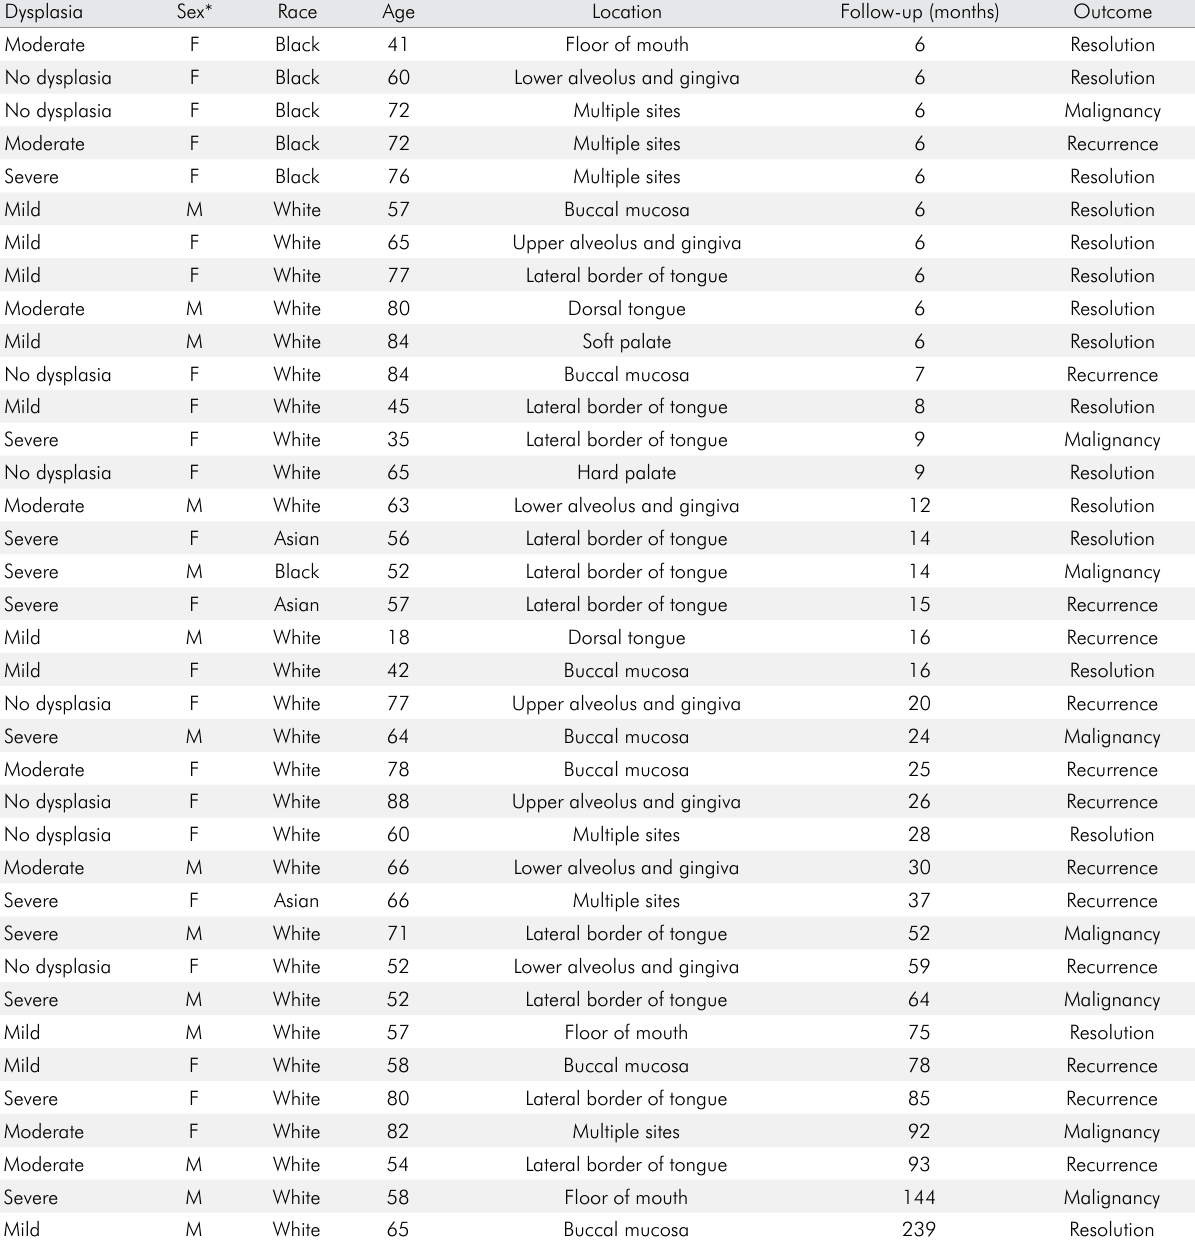
Table 2. Details of clinical and histopathological characteristics of patients diagnosed with oral leukoplakia and treated with CO laser, with their respective clinical